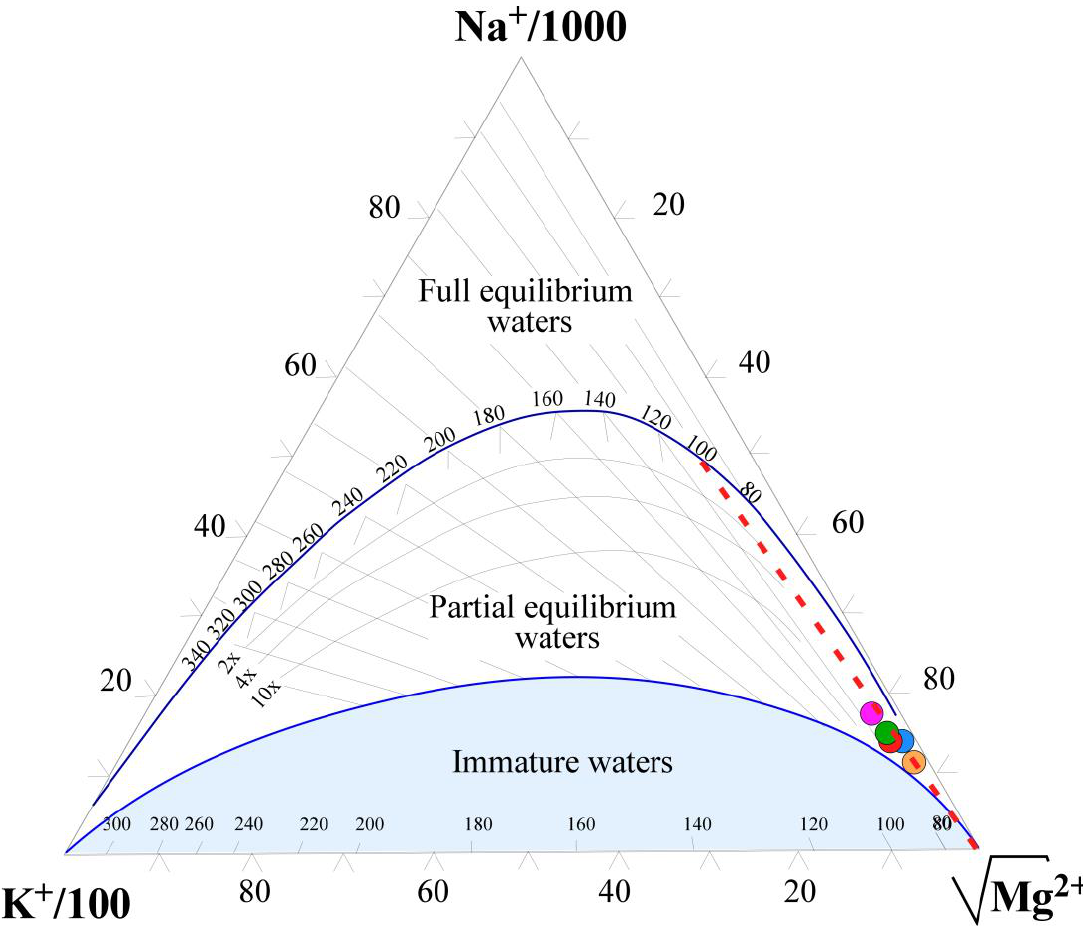
Figure 9. Na-K-Mg 1/2 diagram applied to the thermomineral waters of Goutitir (after [38]). Symbols as in Figure 4, red dash line indicate the equilibrium temperature.